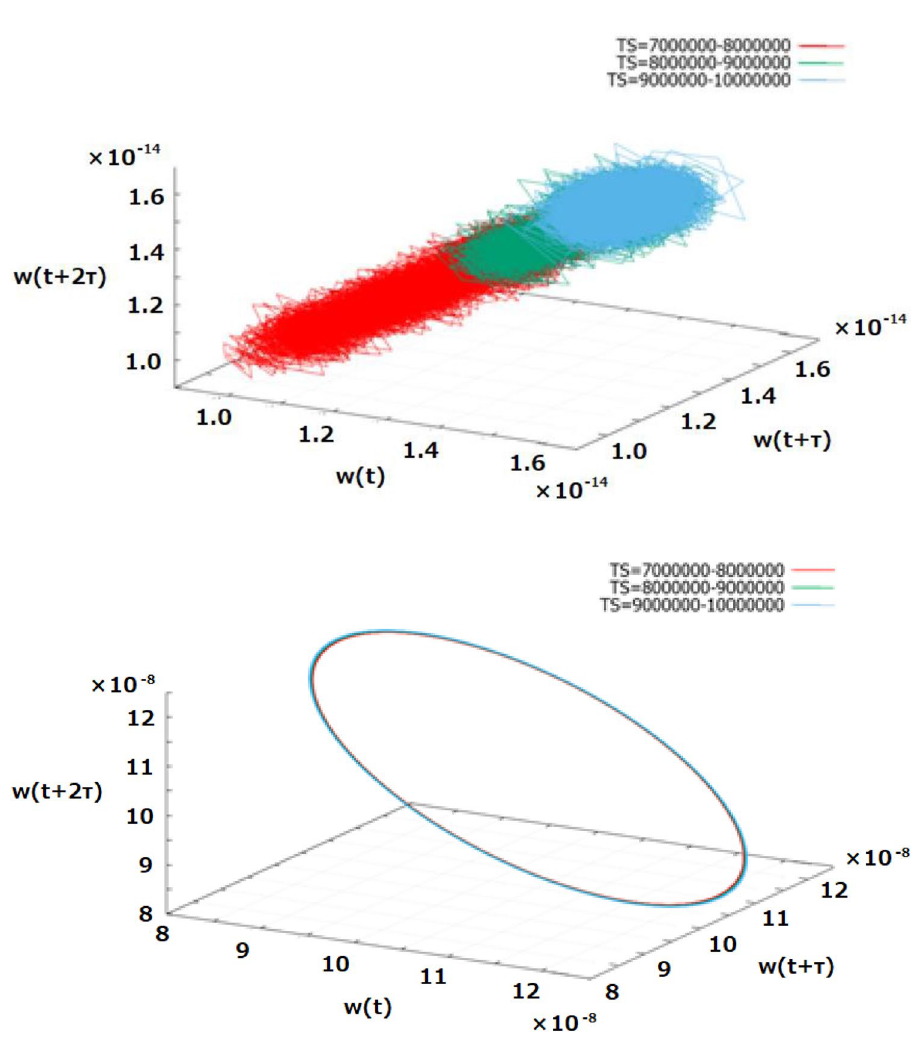
Fig. 10 Attractor of 2-vortex mode at Γ = 2.6, Re = 960 (TS = 7 million to 10 million). The numerical dimensionless